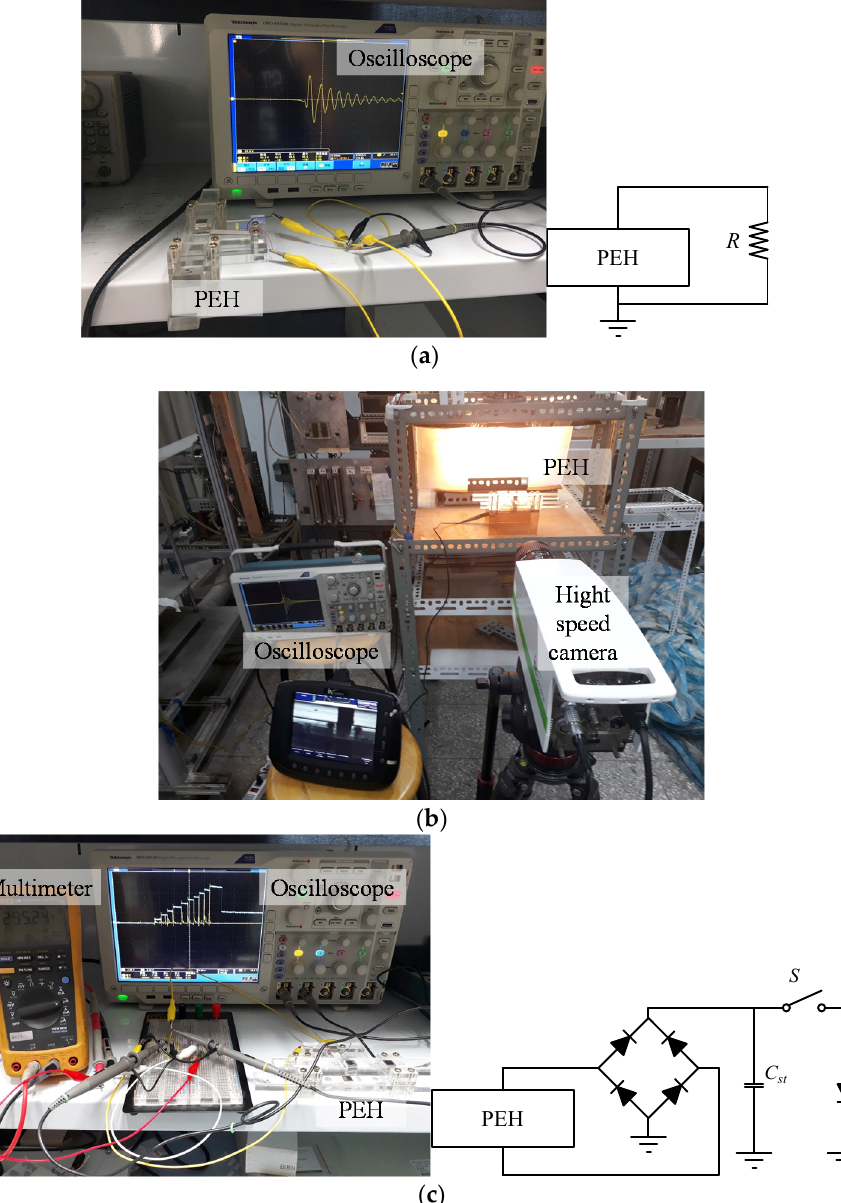
Figure 6. The experimental setup of the PEH: ( a ) voltage measurement of the PEH coupled with a